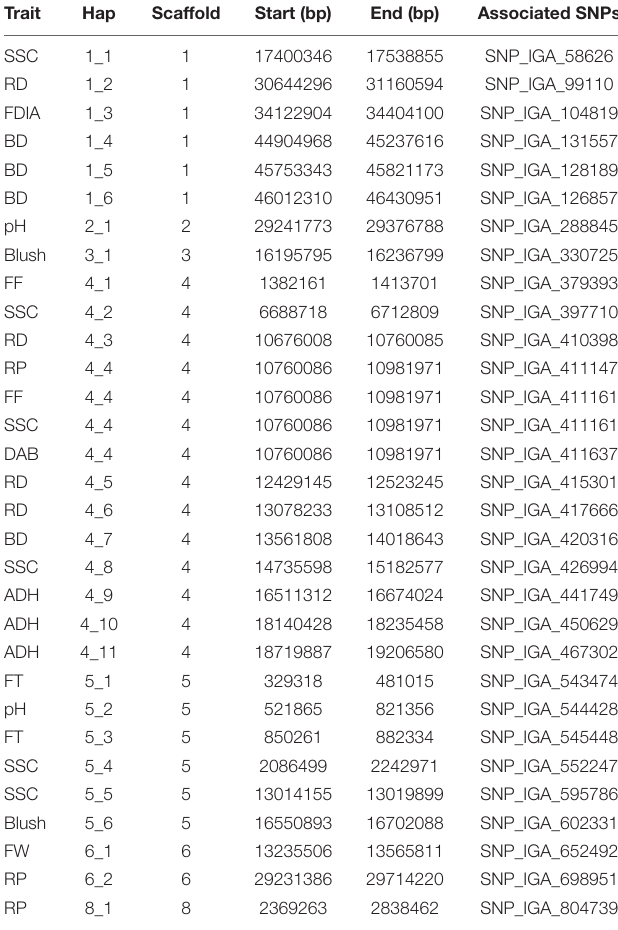
TABLE 5 | Haploblock regions encompassing SNPs markers significantly associated with fruit quality traits in peach. Trait